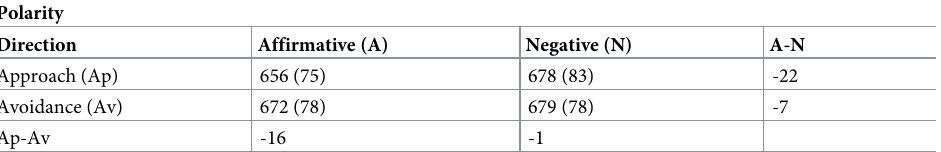
Table 4. Means and standard deviations (in parenthesis) of recognition task latencies for correct responses as a function of Direction and Polarity (delay of 500 ms).